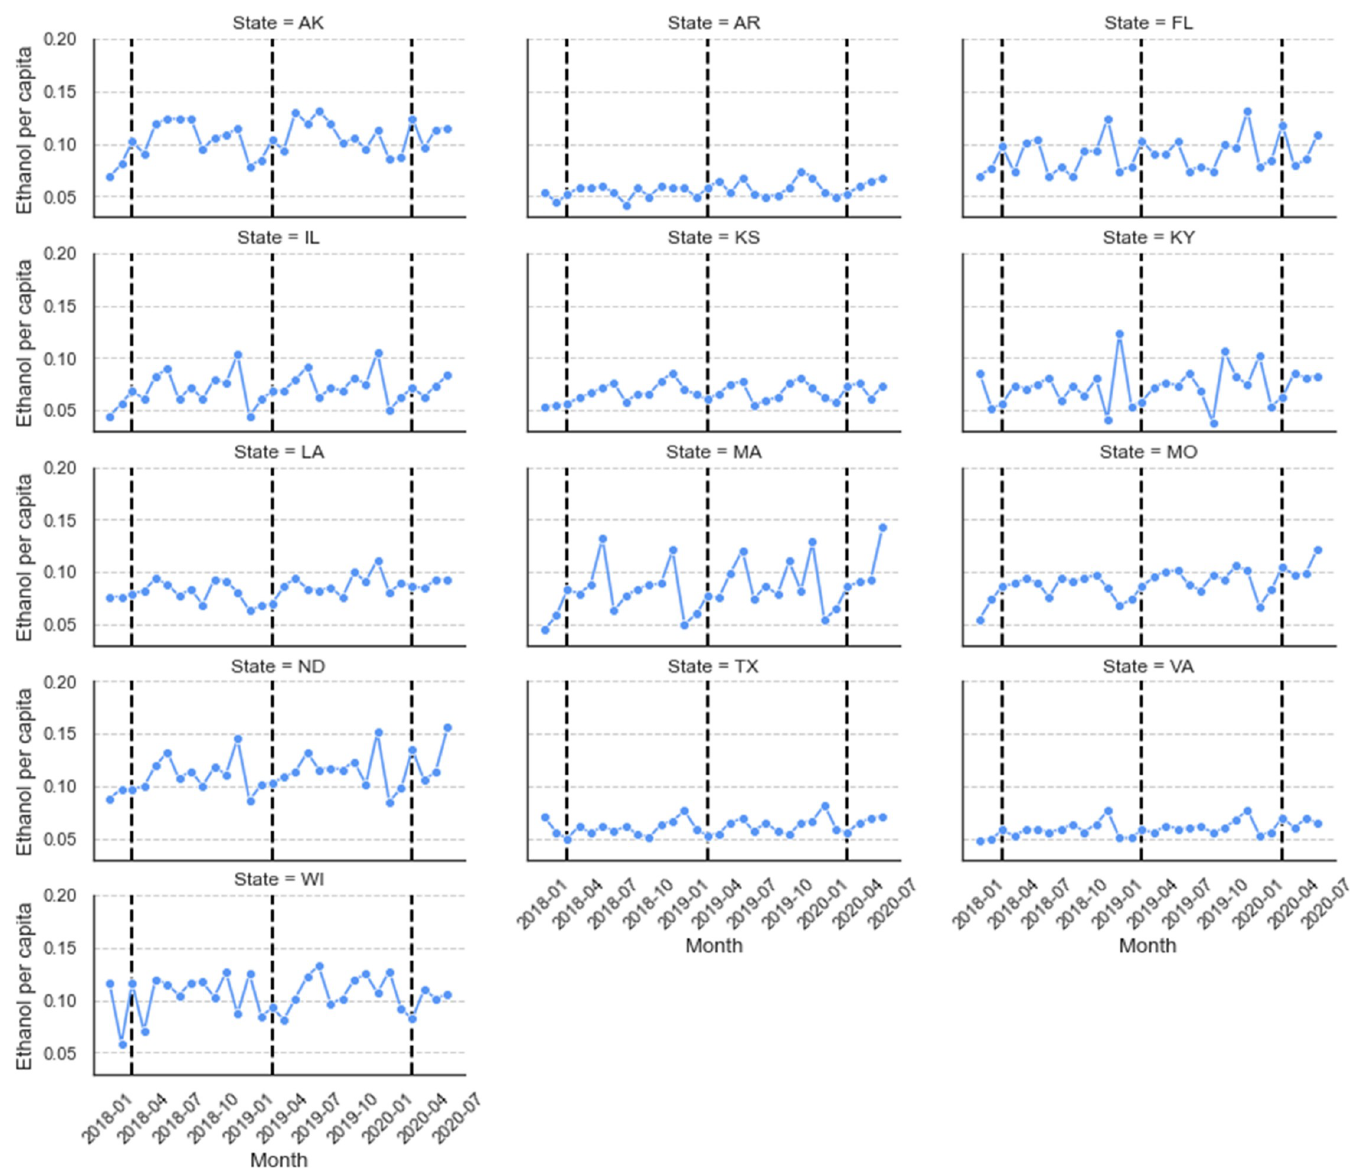
Fig 3. Spirits sales in each of the 13 states (the dashed lines indicate the month of March in 2018, 2019, and